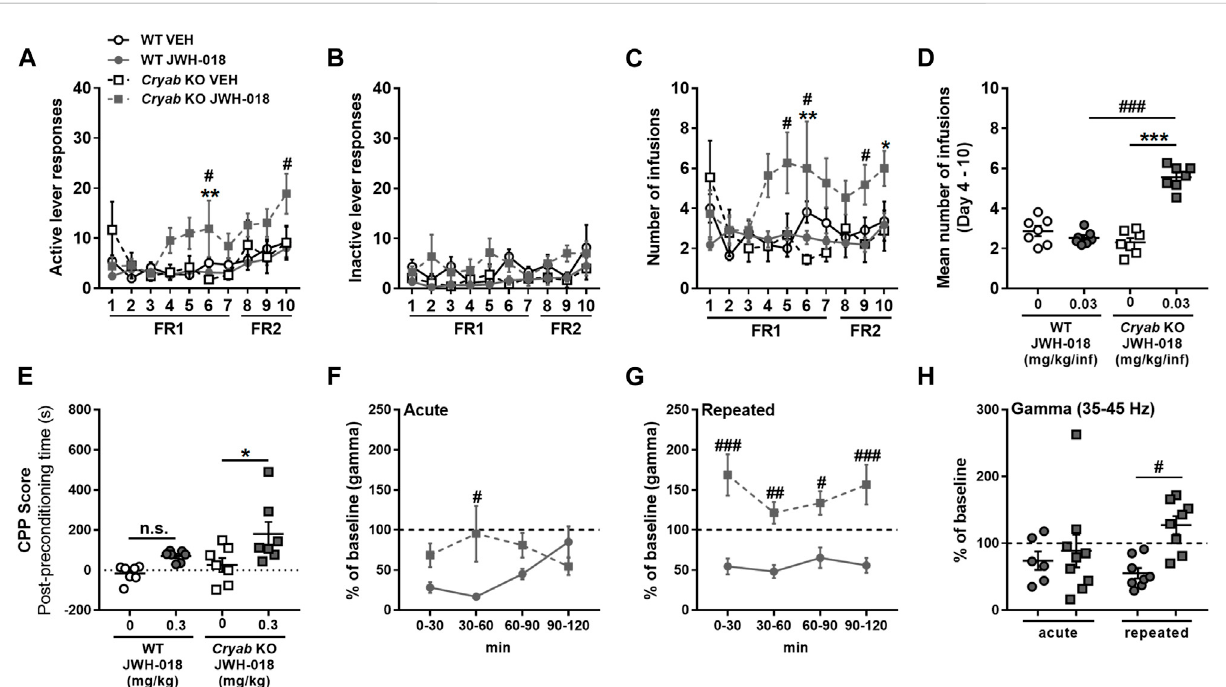
FIGURE 3 Response ofwild-type (WT) and Cryab knockout(KO)miceto JWH-018addiction-related behavioral paradigms.Self-administration(SA)responses ofmice are indicated by (A) active and (B) inactive leverresponses and the (C) number ofinfusions, alongwith (D) mean number ofinfusions, whichwere recordedeachdayfora2-hsession. n =9 – 11.Placepreferenceisindicatedby (E) Conditionedplacepreference(CPP)scoreofmice,whichisobtainedby the difference between thestay duration of mice inthe drug-paired compartment between post- and pre-conditioning. n = 7. Changes in gamma- wave power of mice after (F) acute or (G) repeated treatments over 30-min bins were determined by 2-h electroencephalography (EEG) recordings, and the2-haverages (H) werecompared. n =6 – 9.Dataexpressedasmean±S.E.M. * p < 0.05,** p < 0.01,and*** p < 0.001(vs.VEH;Tukey posthoc analysis). # p < 0.05, ## p < 0.01, and ### p < 0.001 (vs. WT; Tukey post hoc